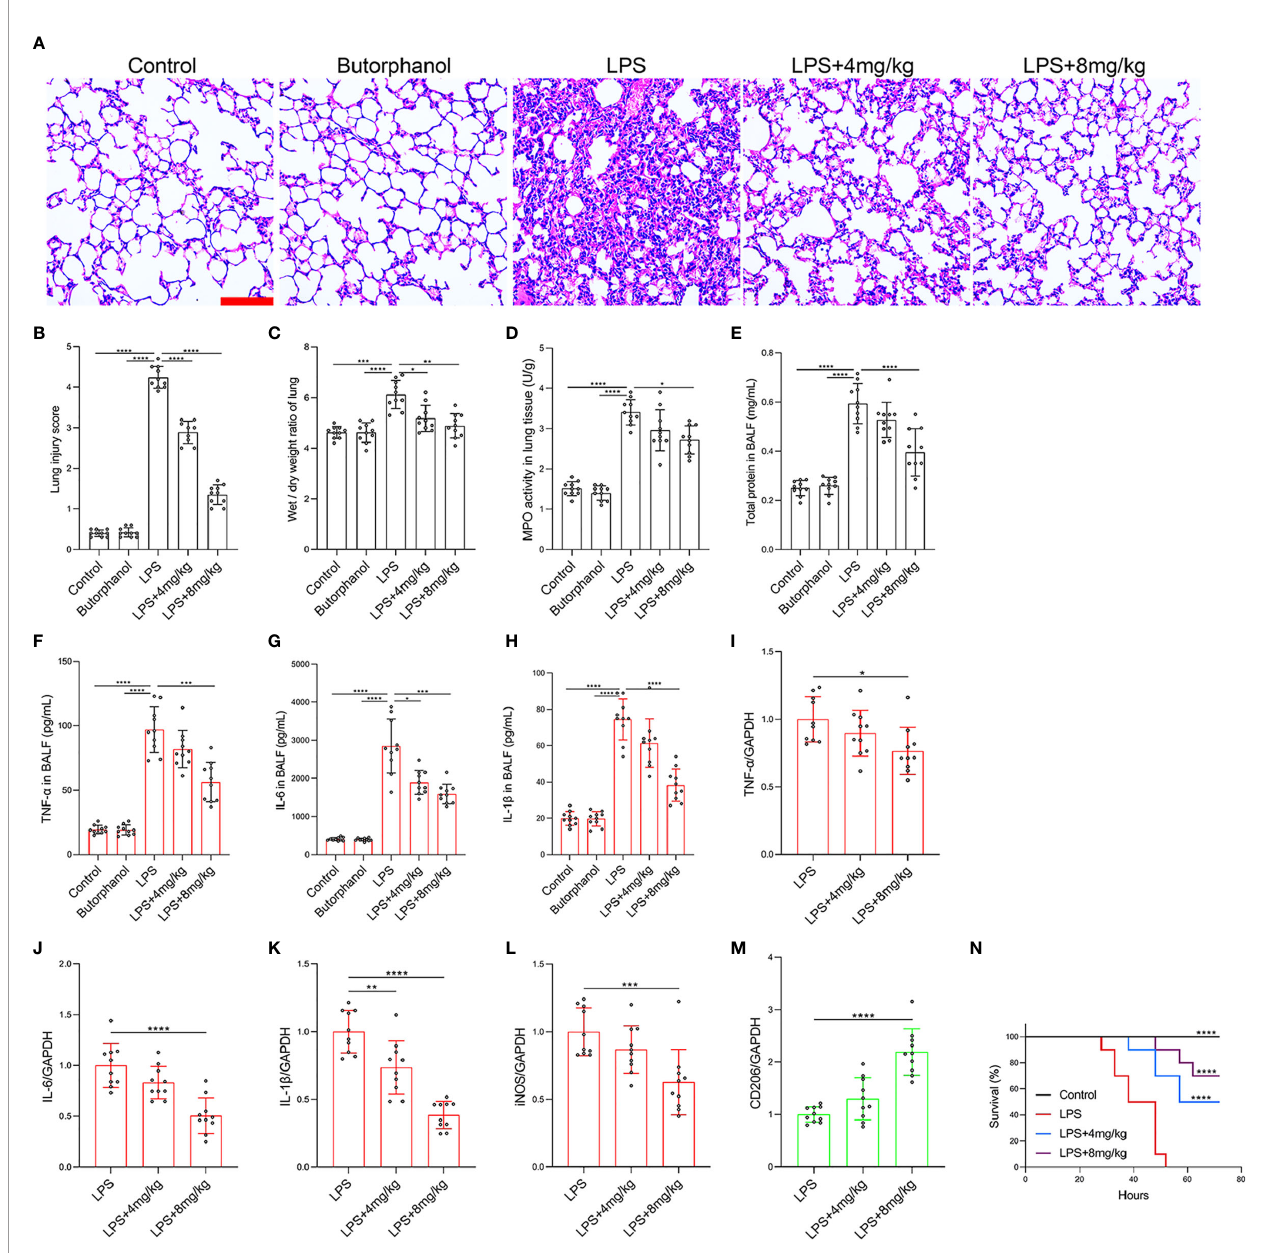
FIGURE 1 | Butorphanol ameliorated LPS-induced in fl ammatory lung injury. Mice were injected with LPS ( 10 mg·kg -1 i.p.) or butorphanol (8 mg·kg -1 i.p.) or butorphanol (4 mg·kg -1 i.p. or 8 mg·kg -1 i.p.) plus LPS (10 mg·kg -1 i.p.) and analyzed after 24 h. (A) Hematoxylin and eosin staining of lung sections. Scale bar: 50 m m. (B) Lung injury score. (C, D) Lungs obtained at 24 h after LPS challenge were used to determine the wet/dry weight ratio and MPO activity. (E) The total protein level in BALF was measured with a BCA assay. (F – H) The BALF expression levels of TNF- a , IL-6, and IL-1 b were determined by ELISA. (I – M) The mRNA levels of TNF- a , IL-6, IL-1 b , iNOS, and CD206 in CD11b+ alveolar macrophages in the BALF of mice were measured with qRT-PCR. (N) Mouse survival was monitored for 72 h after a lethal dose of LPS (20 mg·kg -1 i.p.) alone or in combination with butorphanol (4 mg·kg -1 i.p. or 8 mg·kg -1 i.p.) 30 min after LPS challenge. n = 10 per group. The results are the means ± SEM of ten independent experiments. Statistical analysis was performed by one-way ANOVA followed by Tukey ’ s post hoc test when comparing multiple independent groups and the log-rank test. *P < 0.05, **P < 0.01, ***P < 0.001, ****P <